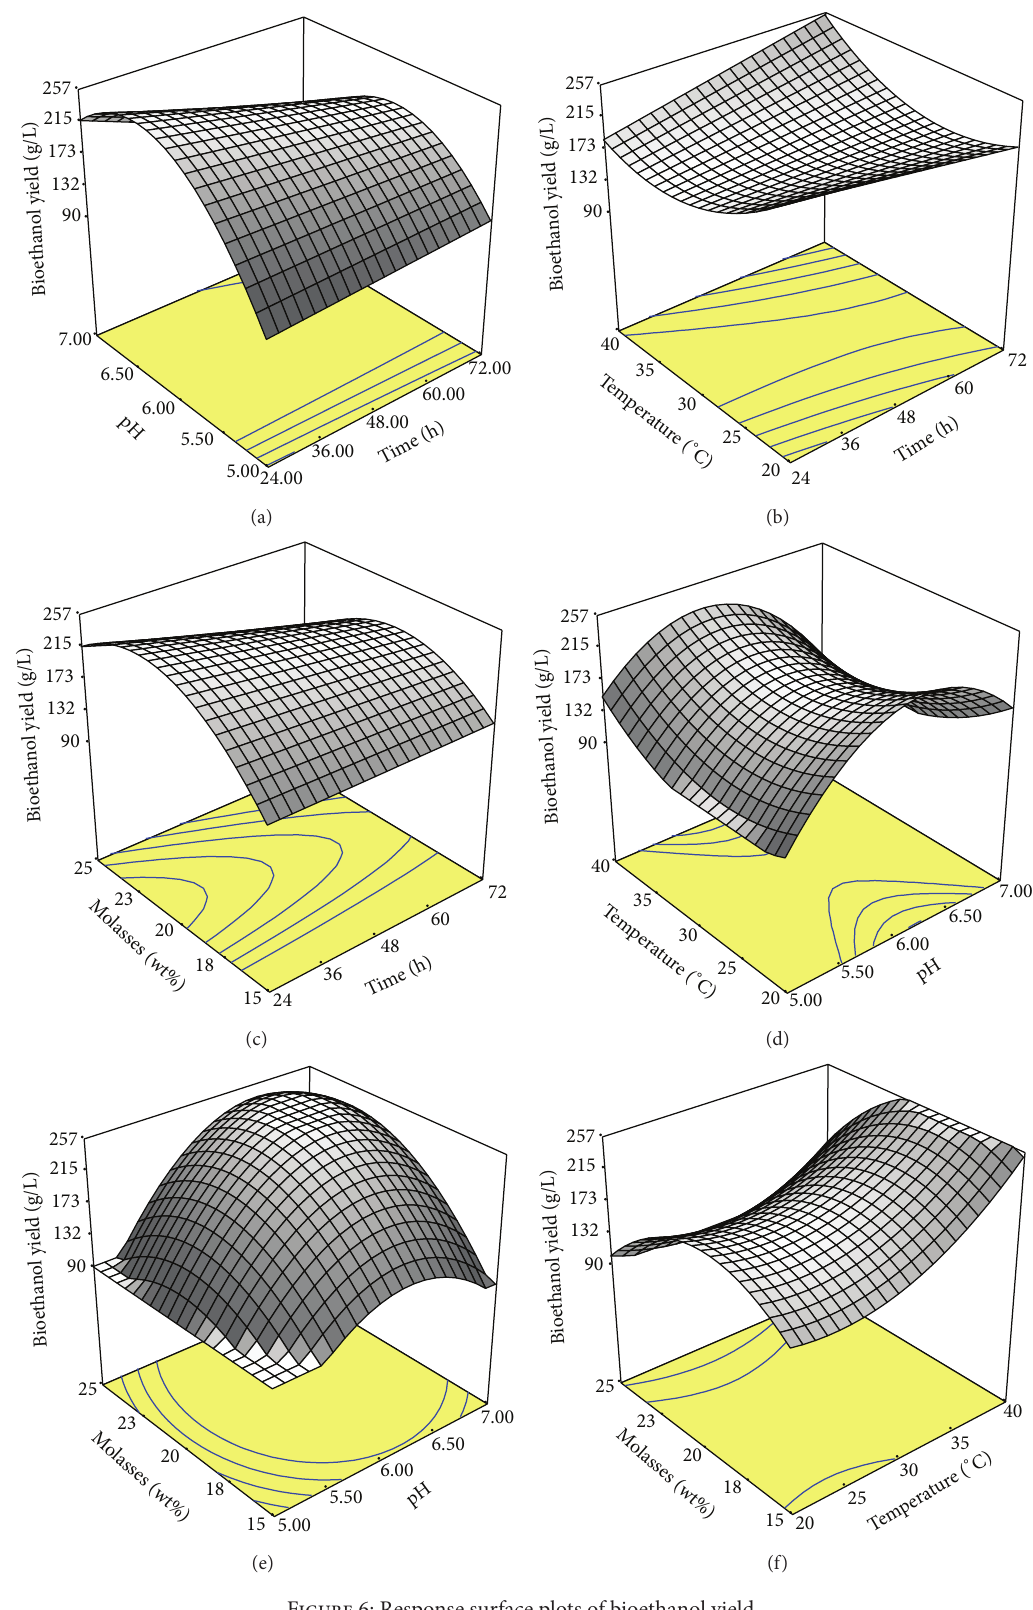
Figure 6: Response surface plots of bioethanol